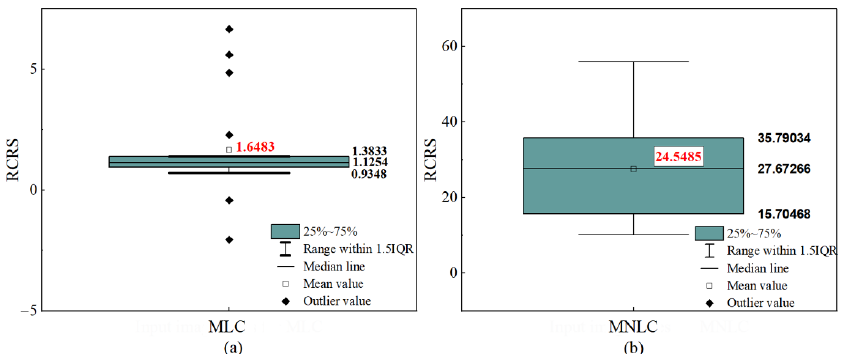
Figure 9. Boxplots of RCRS with CD for ( a ) MLC period and ( b ) MNLC period. The red number represents average value, and the black number is the upper quartile, the median, and the lower quartile from top to bottom.